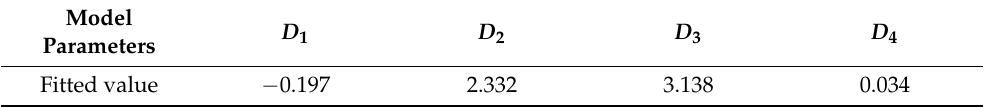
Table 4. Johnson–Cook failure model parameters of the TC4 titanium alloy.